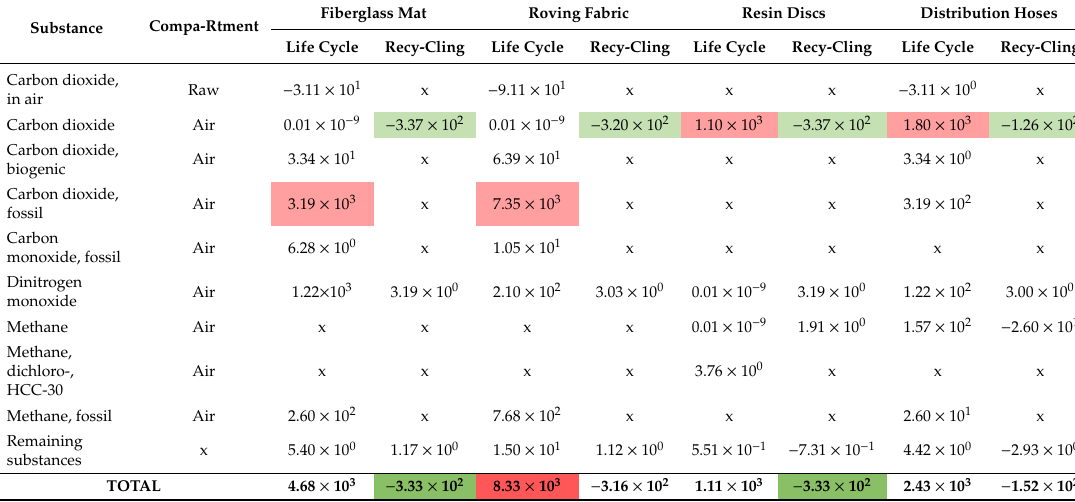
Red highlight—the highest level of negative environmental consequences for the emissions of the analyzed substances. Green highlight—the highest level of positive environmental consequences for the emissions of the analyzed